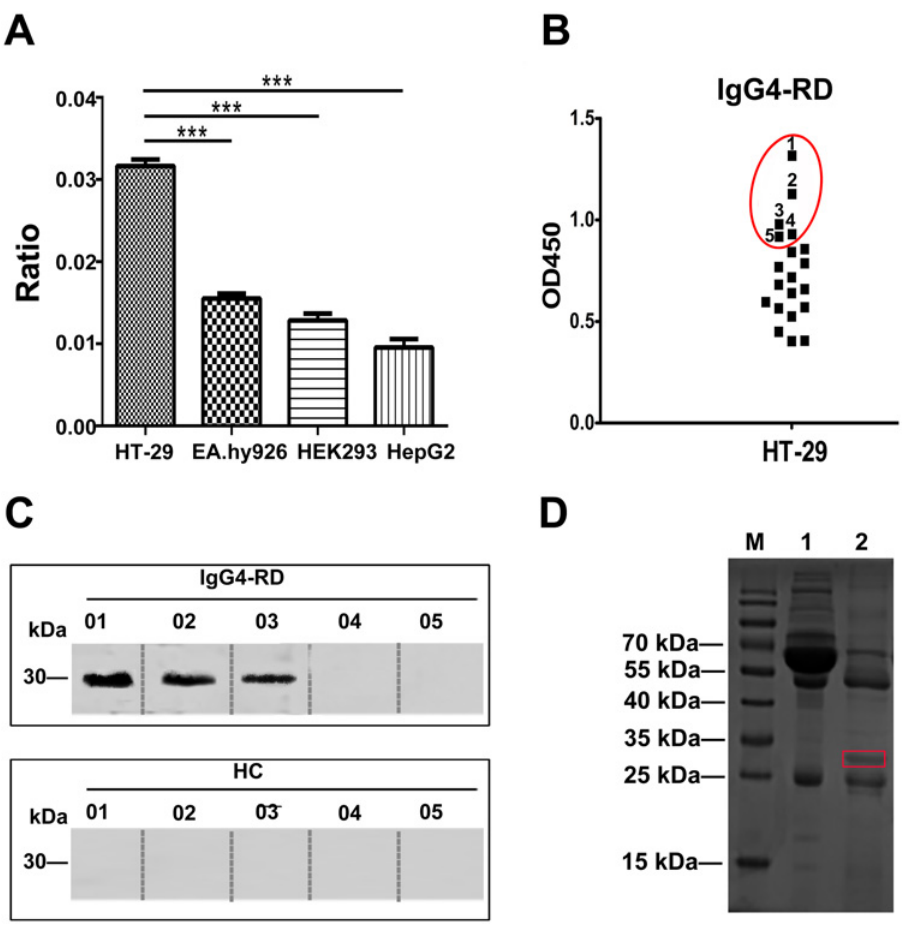
Fig 2. Identification of target antigen. (A) The value of cell fluorescence was analyzed by Image J software. *** indicates P < 0.0001. (B) Five of 20 patients with IgG4-RD presenting relatively higher optical density values on ELISA for HT-29 cell were selected for Western blotting. (C) Western blotting of HT-29 cell extracts with the sera from 5 IgG4-RD patients showed a positive band with a molecular weight of approximately 30 kDa in 3 patients but not in healthy controls. (D) Immunoprecipitation was performed by incubating the extracts of HT-29 with IgG4-RD patient sera and an approximately 30 kDa protein band reacted with antibodies from IgG4-RD